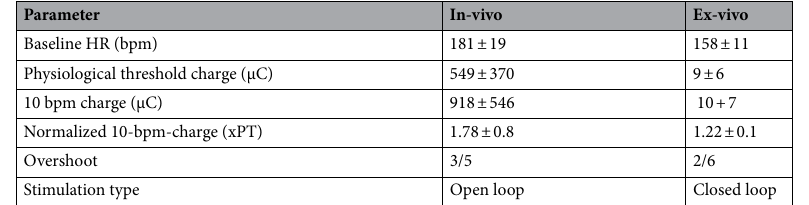
Table 2. Mean baseline heart rate and charges required to reach a reduction of heart rate by 5 bpm (physiological threshold charge) and 10 bpm (10-bpm-charge), respectively. 10-bpm-charges were normalized to enable a comparison between both stimulation strategies in-vivo versus ex-vivo. Overshoot responses describe cases of short heart rate increases by 5 bpm after heart rate has returned to baseline after stimulation was turned off. xPT: physiological threshold charge. Data are given as mean and standard